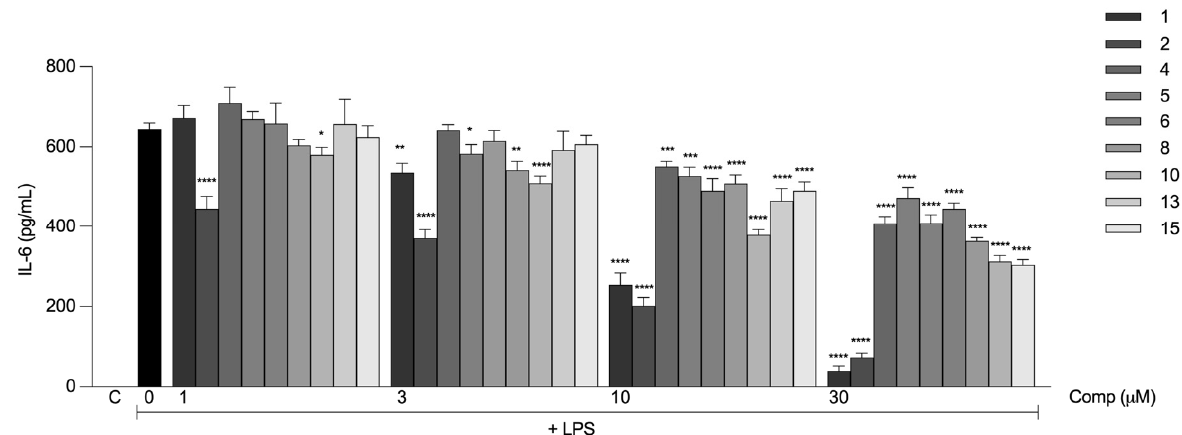
Figure 4. Monofunctionalized curcumin derivatives inhibit the production of IL-6 in macrophages induced by LPS. Peritoneal macrophages from C57BL/6 mice were pretreated with different concentrations (1, 3, 10, or 30 µ M) of the compounds 1 h before stimulation with 10 ng/mL LPS. After 6 h, the concentrations of IL-6 in the supernatants of the cells were determined. All results are presented as the mean ± S.E.M. from three independent experiments performed in triplicate. *, p < 0.05; **, p < 0.01; ***, p < 0.001; ****, p < 0.0001 relative to LPS stimulus alone (black bar). C, negative control.